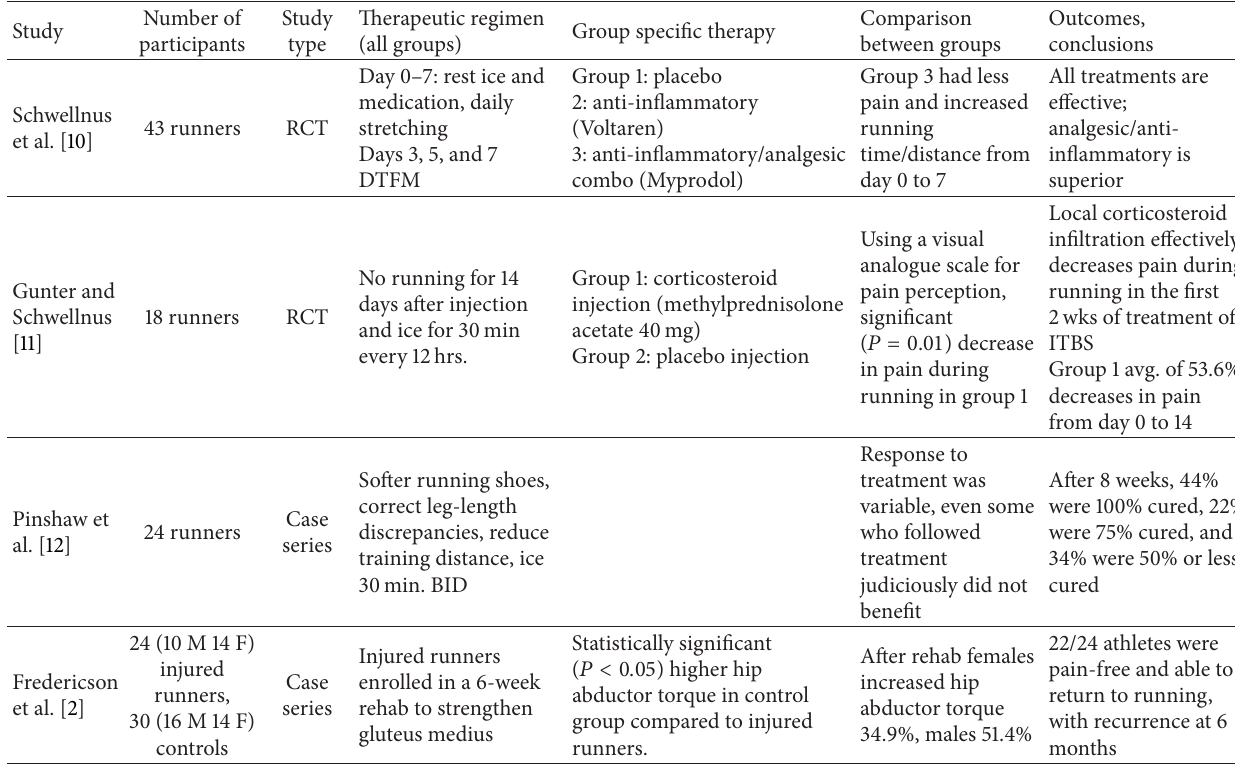
Table 1: Conservative